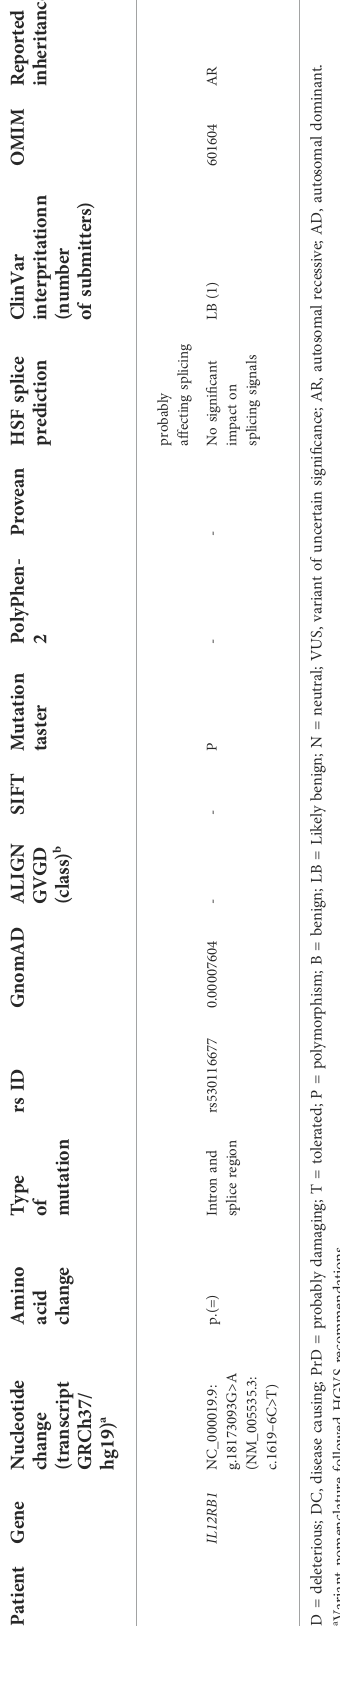
Swiss ExPASy (Expert Protein Analysis System) Molecular Biology Server was used to predict the effects of identi fi ed mutations in HEATR3 , STAT1 and GBP2 genes on the protein structure. The de novo deletion (-AA) in the third exon